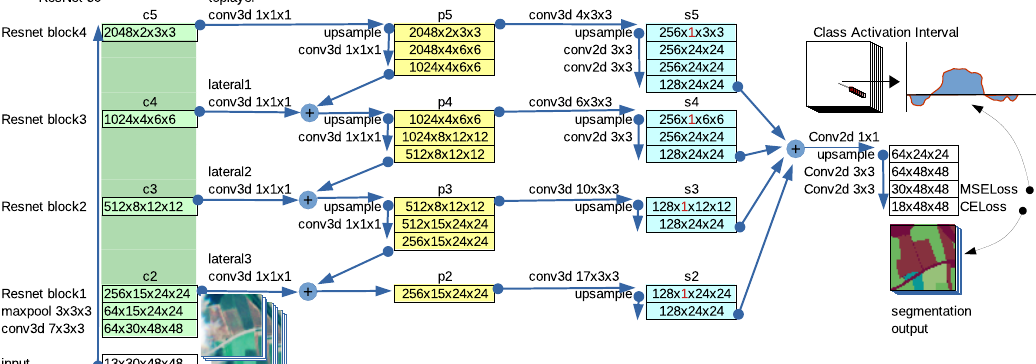
Figure 2. Summary scheme of the proposed convolutional model. The green layers on the left represent the bottom-up pathway, here represented by a modified version of the ResNet 50. The output of the last layer of each block is used to enrich the top-down path (yellow layers) by lateral connection. The feature maps from the bottom-up pathway and the top-down pathway are merged by element-wise addition. This set of feature maps is called { P 2, P 3, P 4, P 5 } , corresponding to { C 2, C 3, C 4, C 5 } that are, respectively, of the same shapes. To obtain the last block for prediction { S 2, S 3, S 4, S 5 } , some 3D kernels are used which lead to features maps with a dimension of size 1 that will be removed. The outputs of the last two 2D convolutions are used by the MSE Loss and the Cross-Entropy Loss to calculate the segmentation map and the class activation